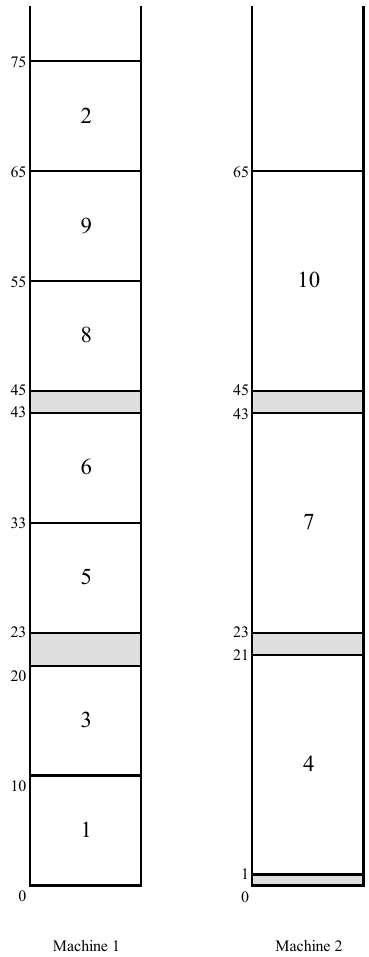
Figure 4. An optimal C-schedule Rev 2,4 ( σ 4,4 ) 2